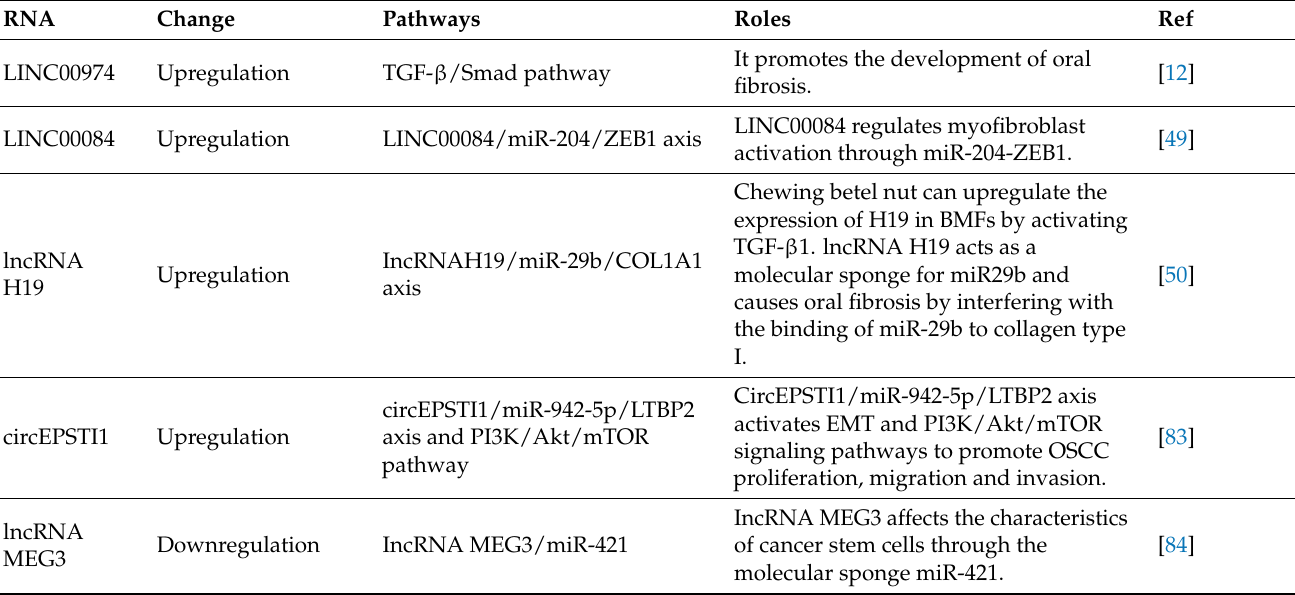
Table 3. Pathways and roles of lncRNAs and circRNAs in OSF and